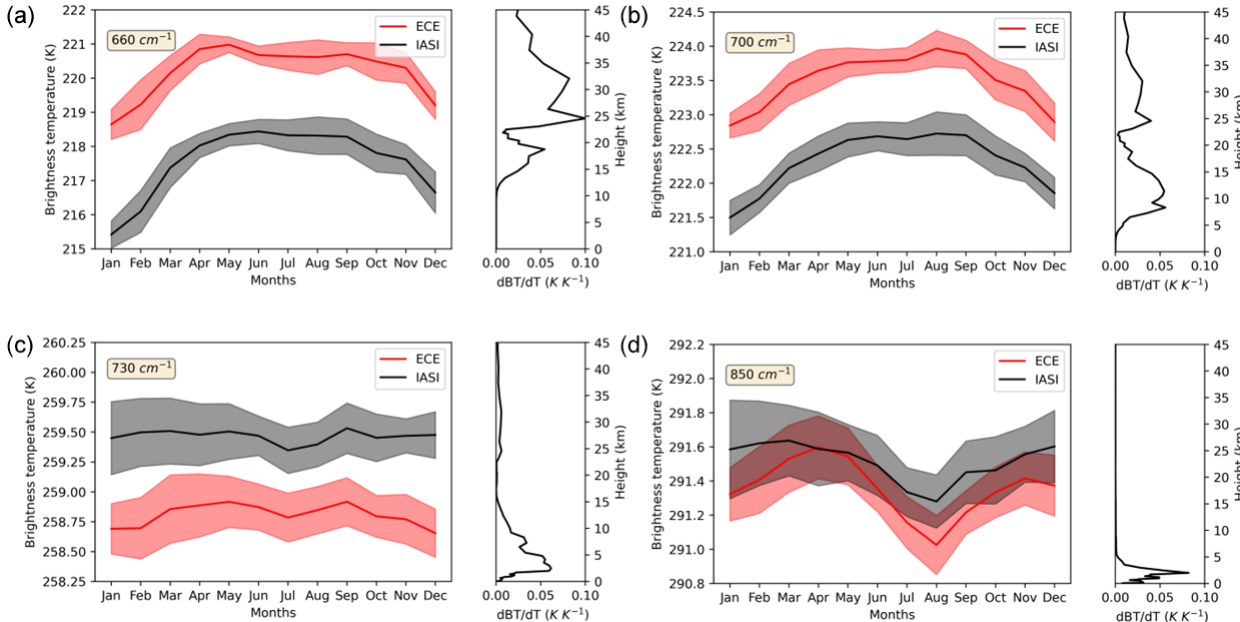
Figure 5. Brightness temperature (BT) averaged in different spectral intervals over tropical ocean (30 ◦ S, 30 ◦ N) and their respective Jaco- bians of BT with respect to the temperature. The red line identifies the model BT, while the black line describes the observed BT. The shadow areas represent the standard deviations. Note the different vertical scales used in the